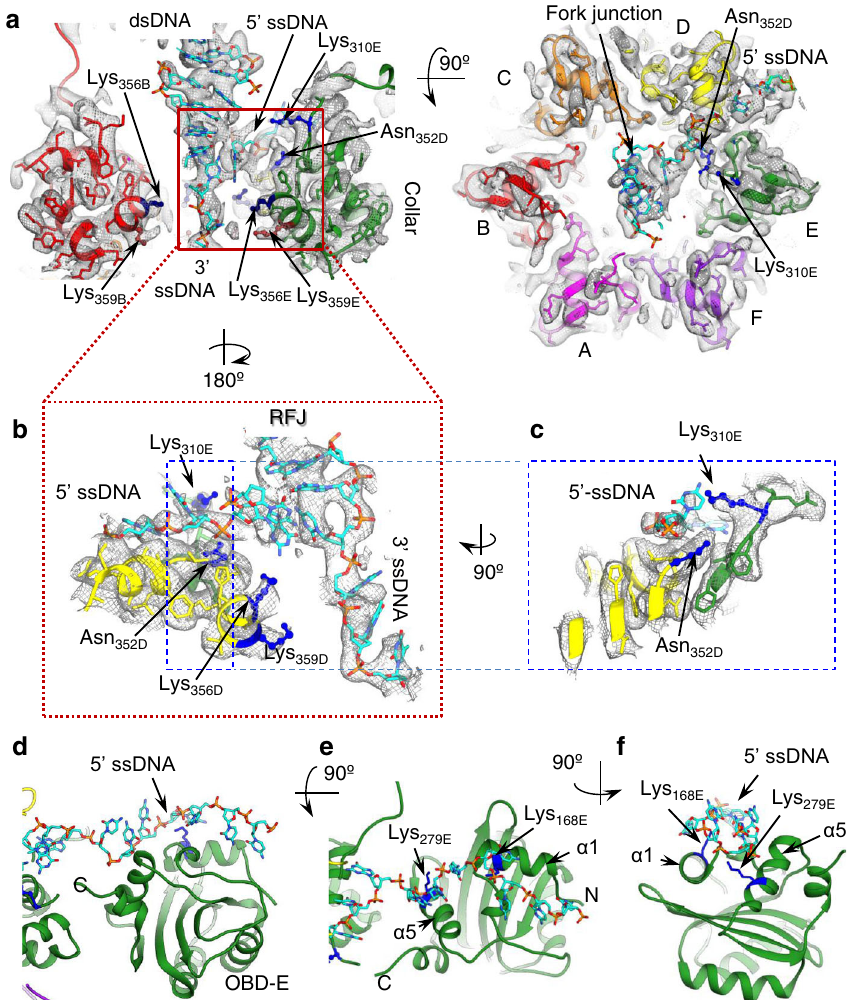
Fig. 5 The exit path of the 5 ′ passive ssDNA strand. a Fitted atomic model of the DNA fork junction in the EM map (grey mesh). Subunit D Asn352 and subunit E Lys310 are indicated. Residues Lys356 and Lys359 are highlighted in dark blue and brown correspondingly. b and c Atomic models fi tted into the EM density map to show the interactions of Asn352 and Lys310 with the ssDNA close to the replication fork junction (RFJ). Locations of residues Lys356 and Lys359 in subunit D are shown in blue. d – f The atomic model of the interaction of the 5 ′ ssDNA with the subunit E OBD, with Lys168 and Lys279